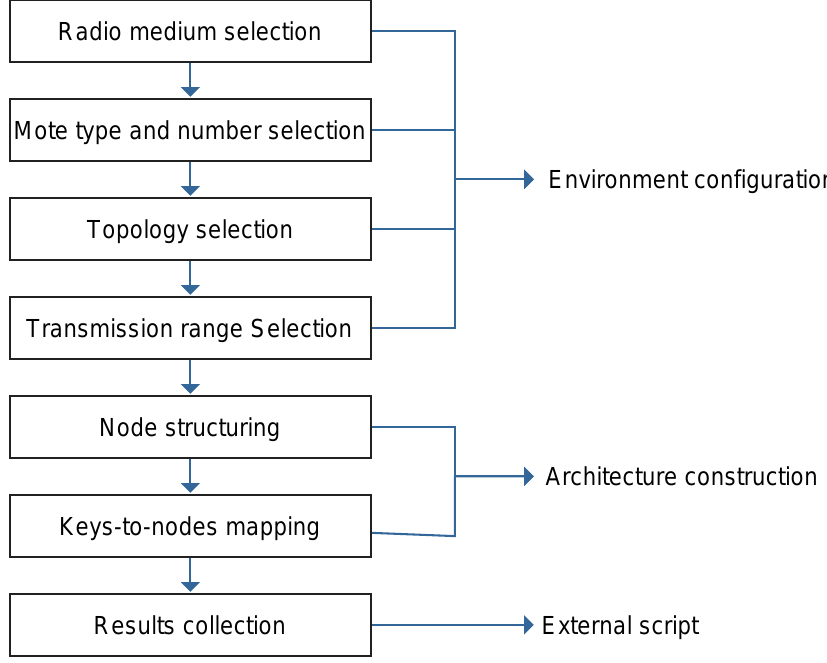
Figure 7. Experimental setup